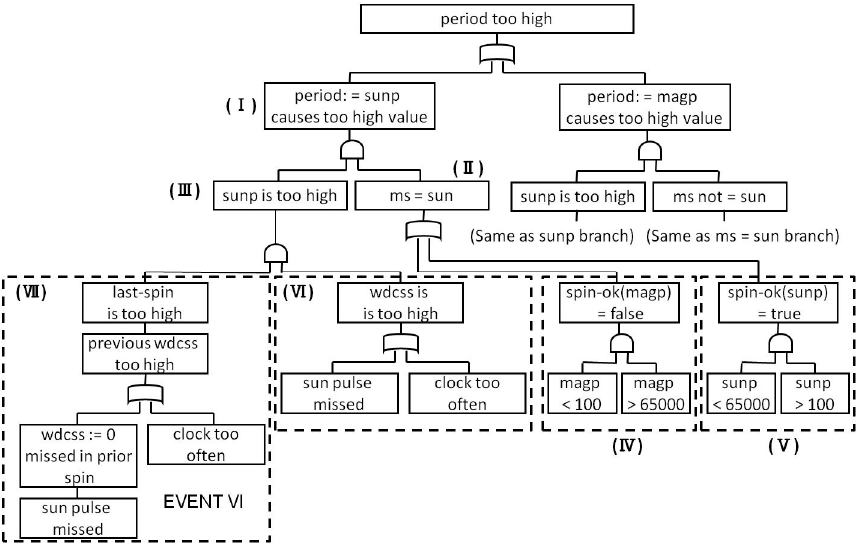
Figure 17. FT developed by Leveson.